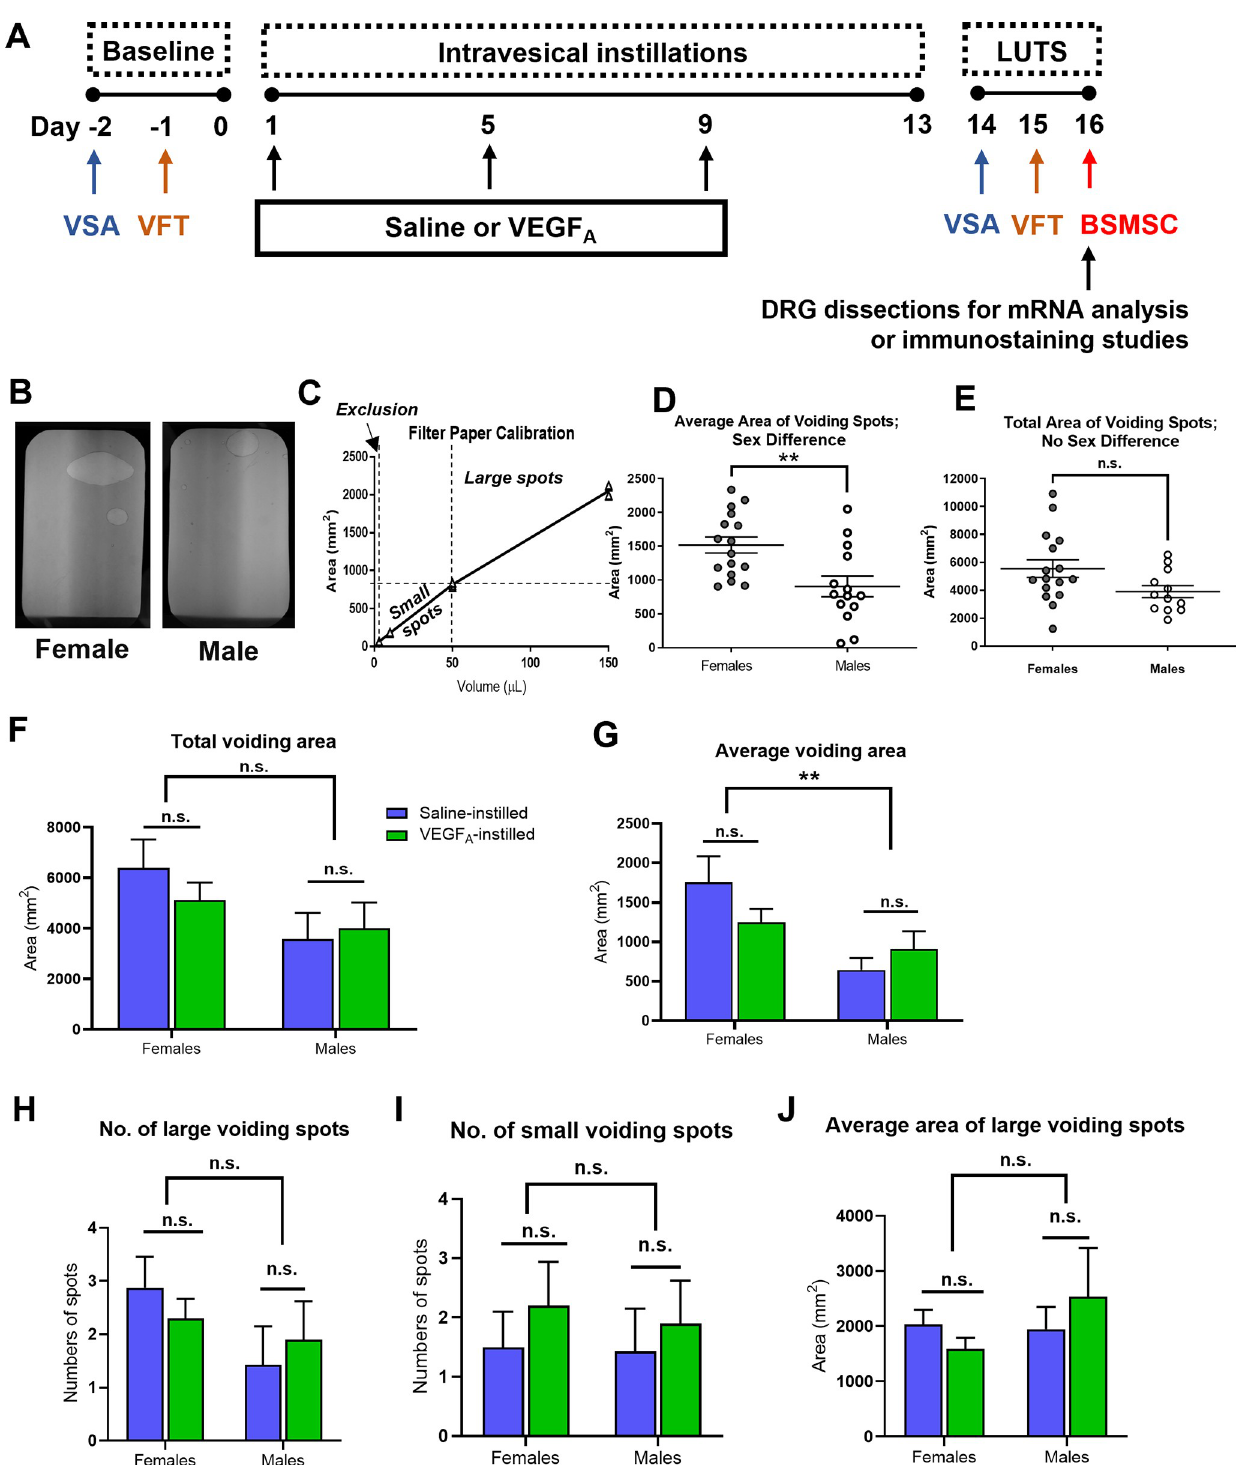
Fig 1. Intravesical instillation of VEGF A did not affect spontaneous voiding behavior in awake mice. (A). Experimental timeline. Voiding spot assays (VSA) and Von Frey tests (VFT) were performed before (baseline) and after the instillations. Bladder smooth muscle strip contractility (BSMSC) recordings were performed at the end of the study. (B). Representative images of voiding patterns in female (left) and male (right) TRPV1-Cre-ZsGreen mice before instillations (baseline). (C). The “area-to-volume” standard curve in VSA. (D). Sex differences were detected in the average area of voiding spots (the average volume of each voiding) at baseline. (E). No sex differences were identified in the total area of voiding spots (total volume of voiding) at the